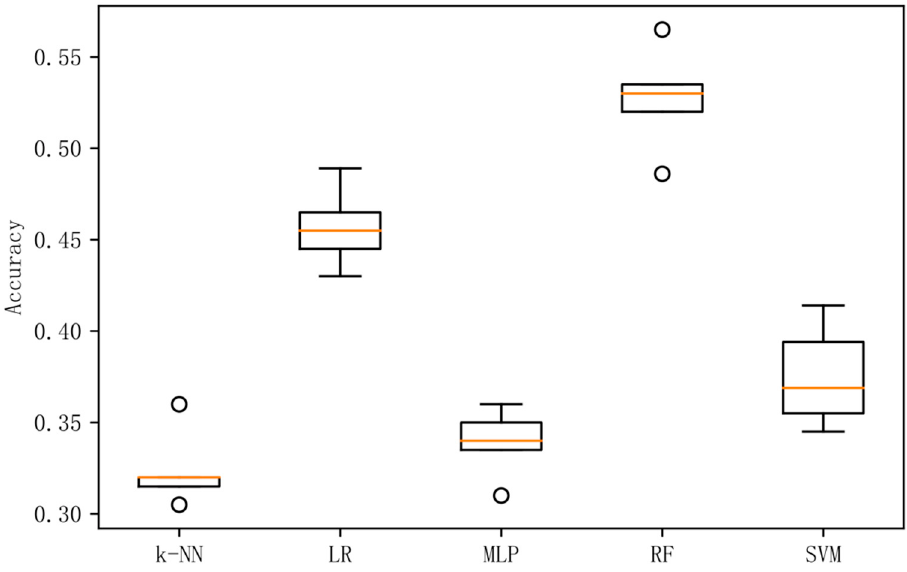
Figure 3. Accuracy in original dataset based on LDA with five